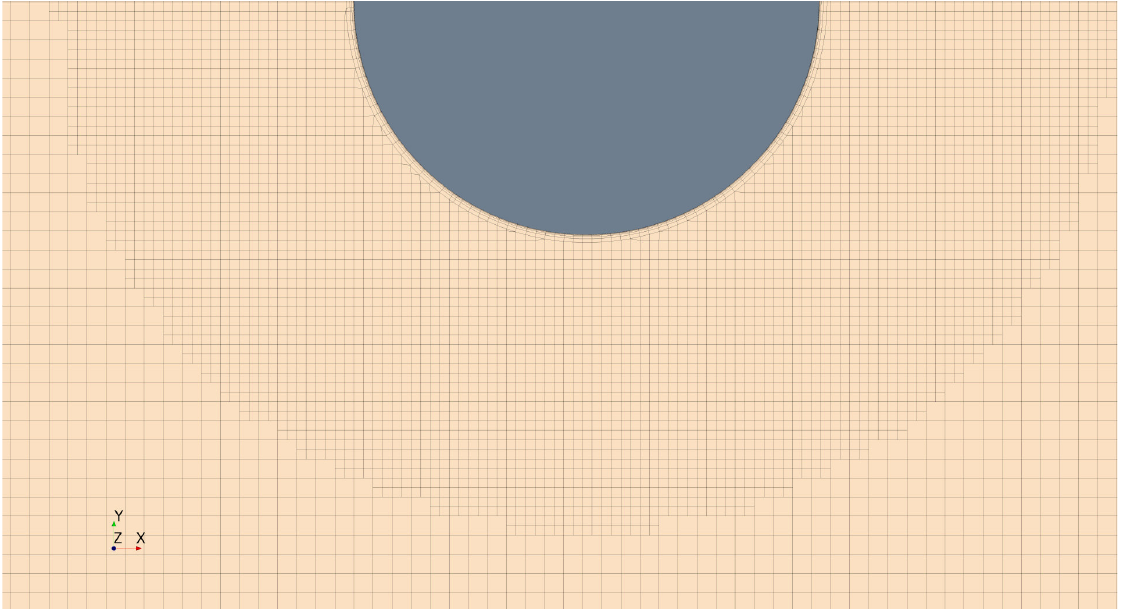
Figure 2. Top view of one half of the grid refinement in the vicinity of the large cylinder at z = 0 m.